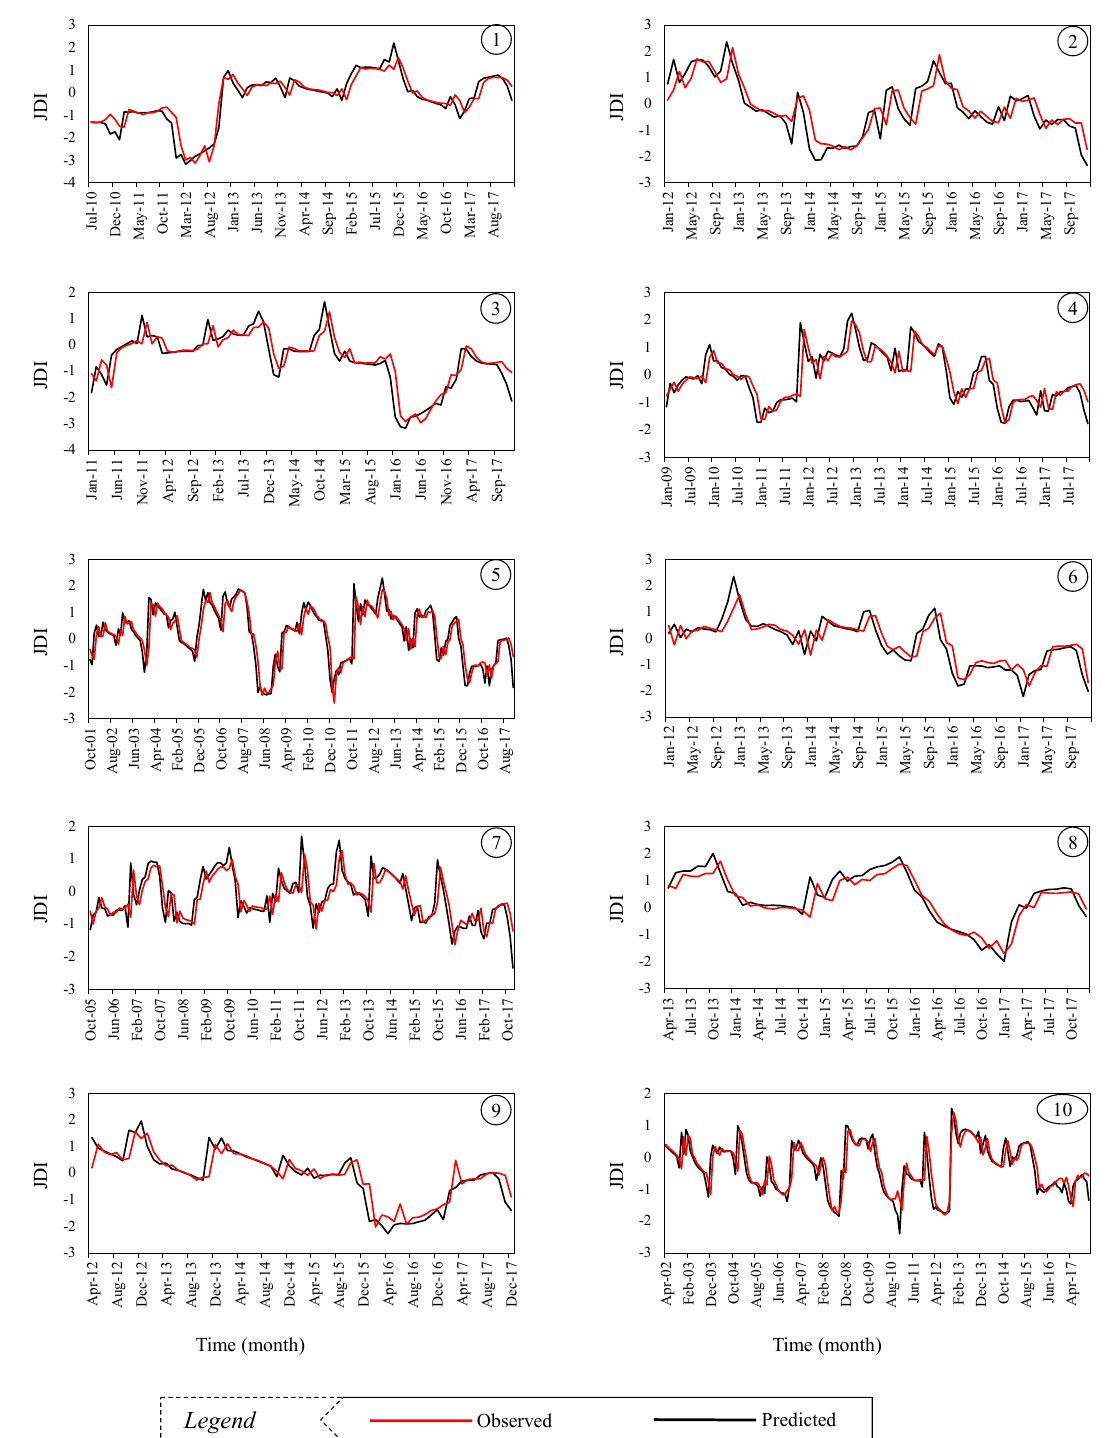
Figure 4. The variation of forecasts and observations for the MSPI prediction in all of the stations; The numbers of the subplots refer to the stations including Anar (1), Biarjmand (2), Boshrouyeh (3), East Isfahan (4), Isfahan (5), Kabootarabad (6), Kashan (7), Marvast (8), Naein (9) and Yazd (10).